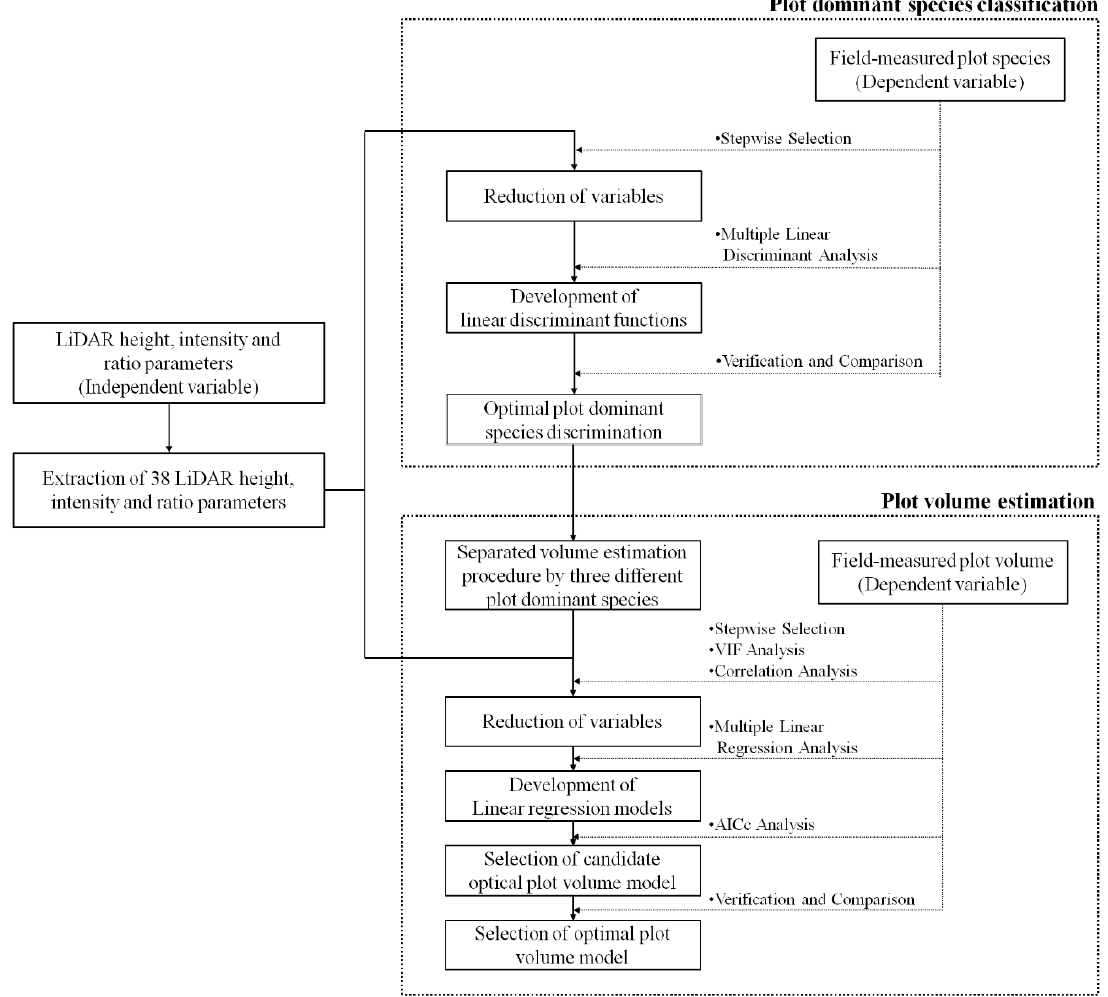
Figure 2. Flowchart of plot dominant species classification and plot volume estimation.